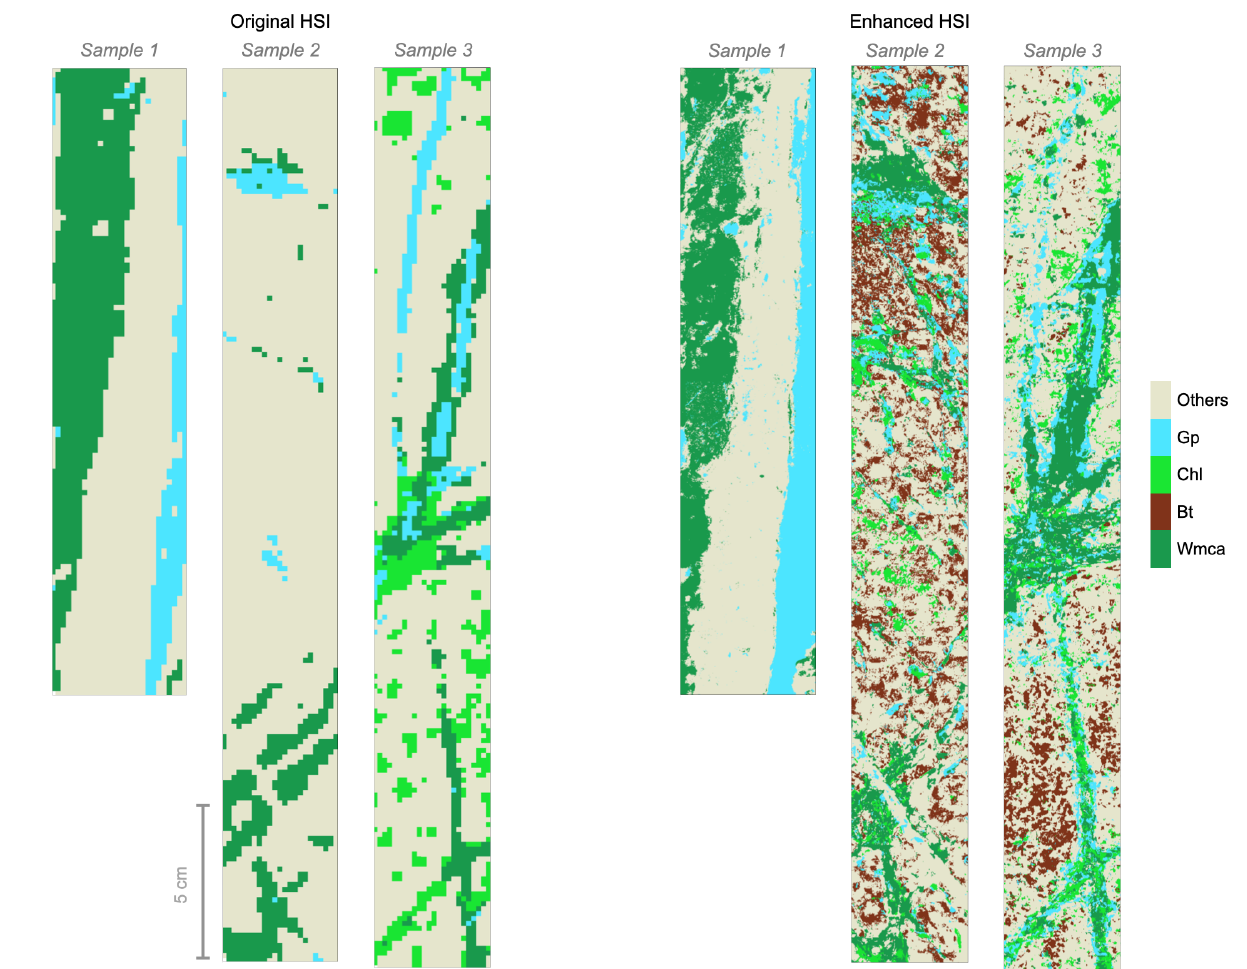
Figure 9. Classified maps obtained by selecting training samples from the co-registered and resampled scanning electron microscopy—mineral liberation analysis (SEM-MLA) data and by classifying the enhanced hyperspectral (HSI) data on the right side with a sampling of 0.1 mm ground sampling distance (GSD). As a comparison of the proposed method, we also present the classified maps obtained when using the original hyperspectral data (with a sampling of 1.5 mm GSD) on the left side. (Wmca—white mica, Bt—biotite, Chl—chlorite, and